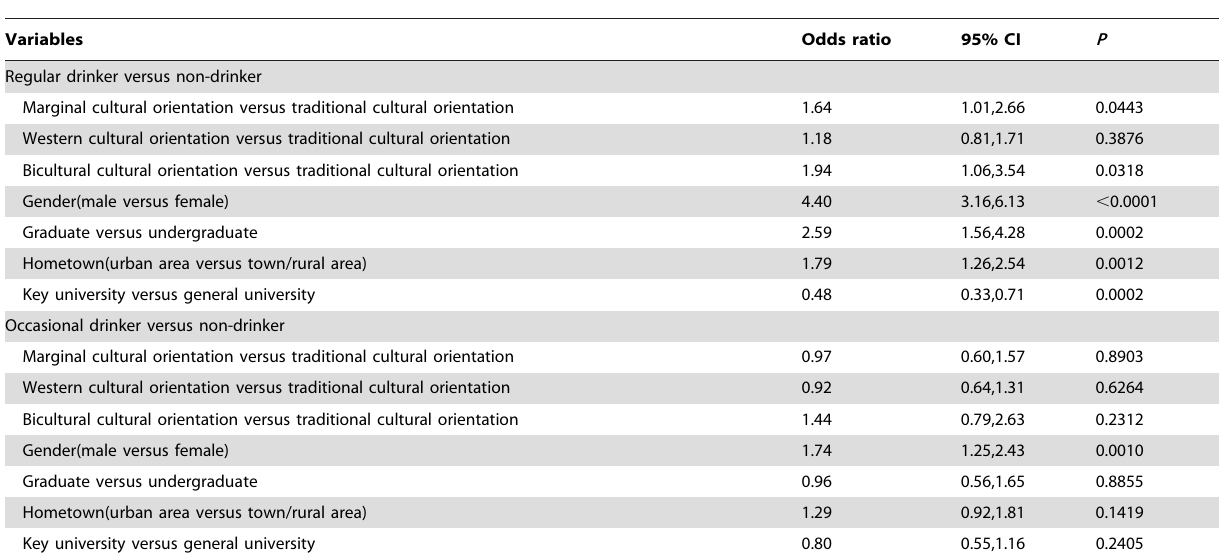
Table 4. Odds ratios for drinking behaviors according to logistic regression